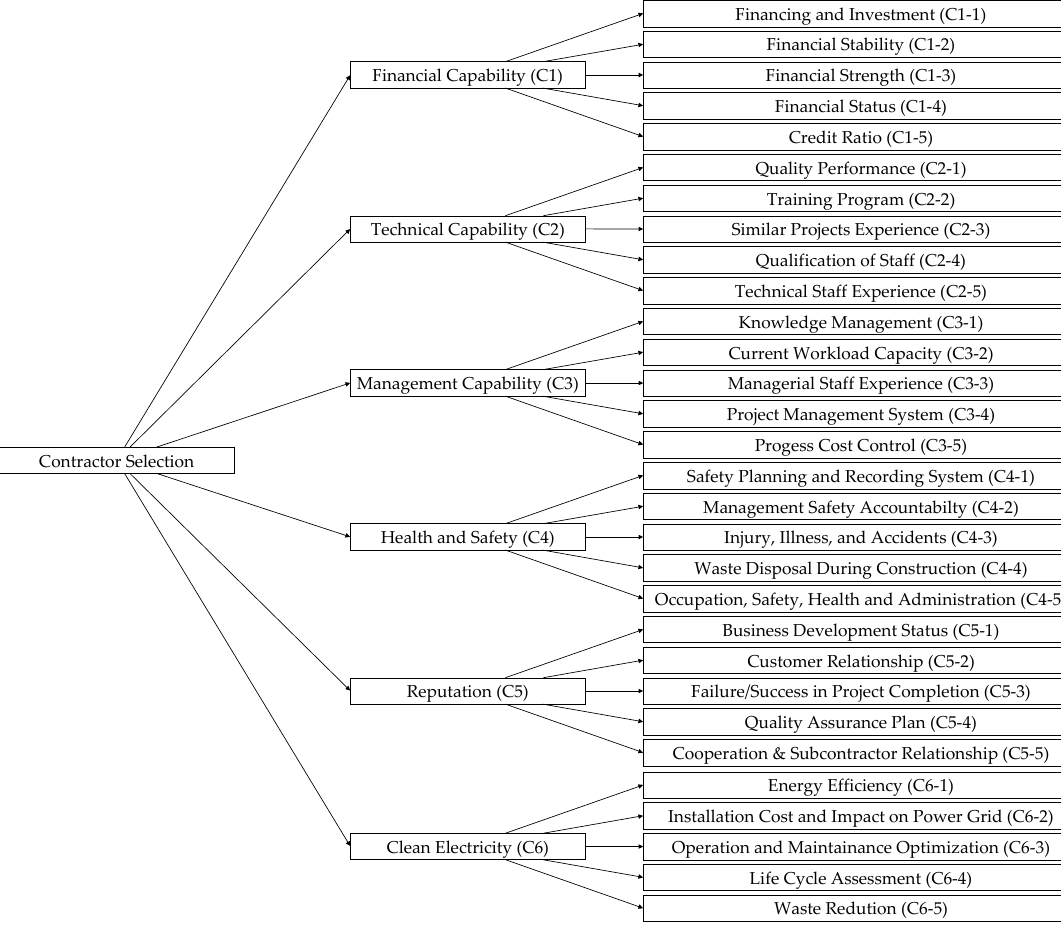
Figure 1. Hierarchical diagram for evaluating solar panel contractor.